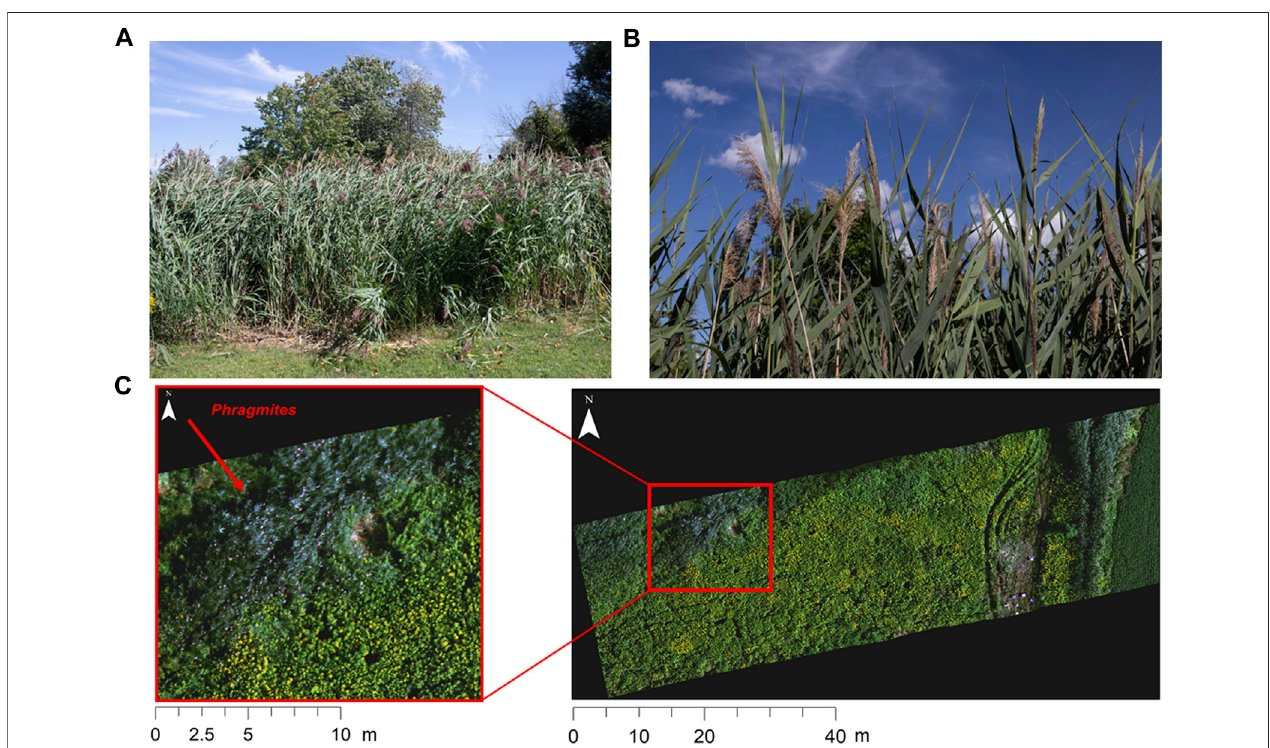
FIGURE 2 | (A) A dense monotypic stand of Phragmites australis subsp. australis found within Îles-de-Boucherville National Park. (B) An example of the brown Phragmitesseedheads. (C) Overheadviewofa Phragmites standandsubsetshowingthecontrastwiththesurroundingvegetation.uCASIhyperspectralimagefroman RPAS platform is shown in RBG bands 637, 550, and 430